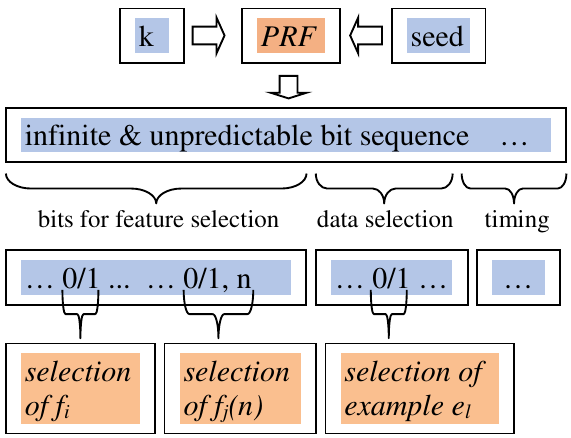
Figure 2. Computing the learning system’s parameters from the secret key